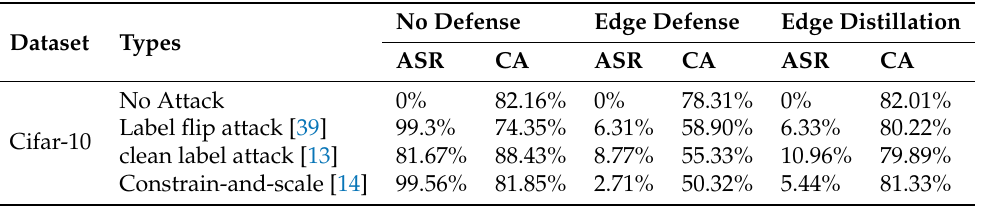
Table 3. The attack success rate (ASR%) and clean accuracy rate (CA%) of three backdoor defense methods against seven backdoor attacks, including label flip attacks, clean label backdoor attacks, and constrain-and-scale. None means the training data are completely clean.